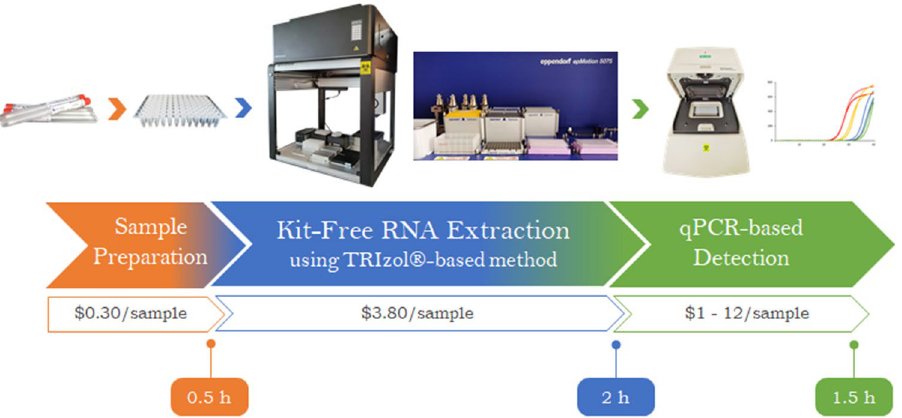
Figure 1. Scalable high-throughput kit-free RNA extraction workflow. Biological samples are manually transferred into a 96-well PCR plate and total RNA extraction was carried out by automated liquid handlers using a modified TRIzol-based method. Manual intervention is required for plate centrifugation. Viral diagnostic analyses is performed on extracted RNA via qPCR-based detection. A complete run of 96